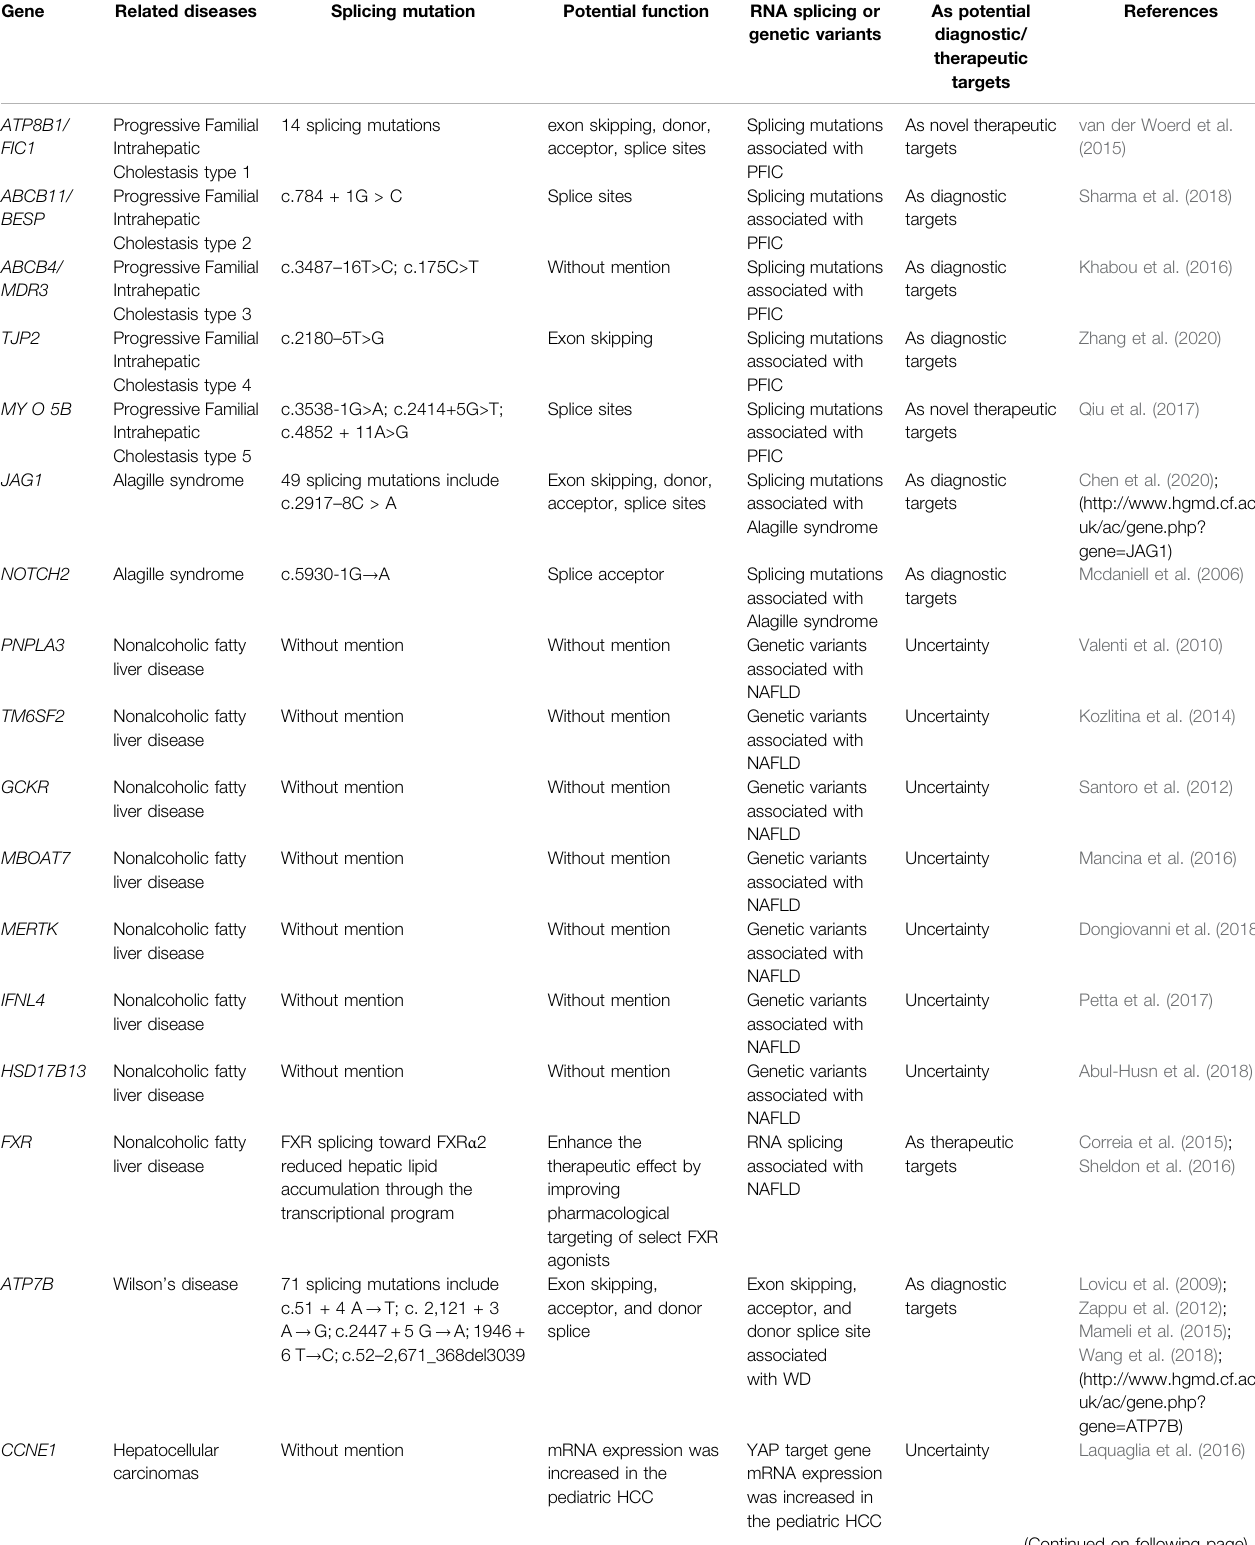
TABLE 2 | Genetic manipulation of RNA splicing in pediatric liver